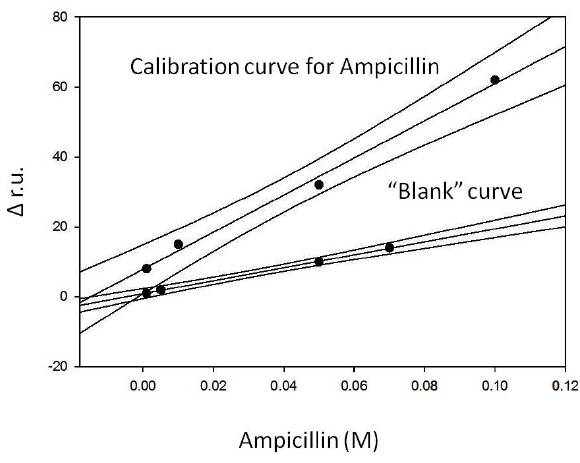
Figure 9. Comparison between blank curve and calibration curve of ampicillin.